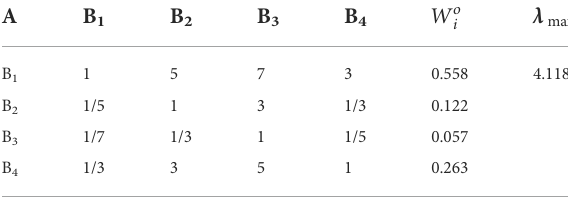
TABLE 5 Weights of second-tier indicators (2).